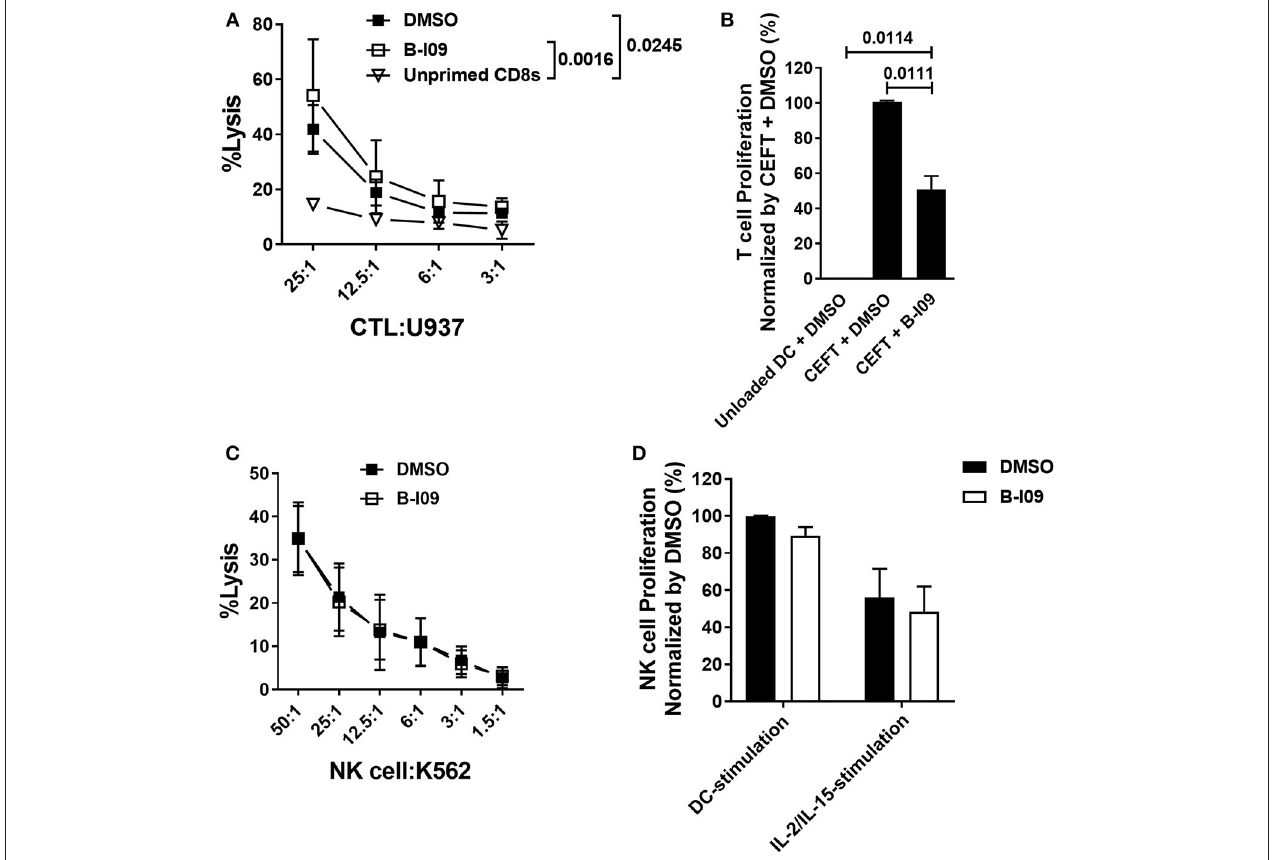
FIGURE 5 | XBP-1s is dispensable for anti-tumor activity by CD8 + cytotoxic T lymphocytes and NK cells. (A) Replicate mean specific lysis by human CD8 + CTL generated in vitro using PBMCs stimulated by irradiated U937cells (1:1) on days 0 and + 7 of a 10–12 day culture. B-I09 or DMSO was added once on days 0 and + 7. Tumor-specific killing by purified CD8 + T cells was determined using fresh U937 cells. U937 lysis was measured by a colorimetric assay after 4h. Triplicate means from 3 independent experiments are shown. (B) T cell proliferation stimulated by autologous moDCs loaded with CMV, EBV, influenza, or tetanus peptides is shown. B-I09 or DMSO was added once on day 0. T cell proliferation (MTS colormetric assay) was measured on day + 3. Replicate means from 4 independent experiments are shown, Dunnett’s test. (C) Mean specific lysis by human NK cells against K562 targets is shown. B-I09 or DMSO was added at the outset of the culture. K562 lysis was measured by a colorimetric assay after 4h. Replicate means from 3 independent experiments are shown. (D) NK cell proliferation stimulated by allogeneic moDCs (moDC:NK cell ratio 1:10) or IL-2 plus IL-15. NK cell proliferation (MTS colormetric assay) was measured on day + 5. Replicate means from 3 independent experiments are